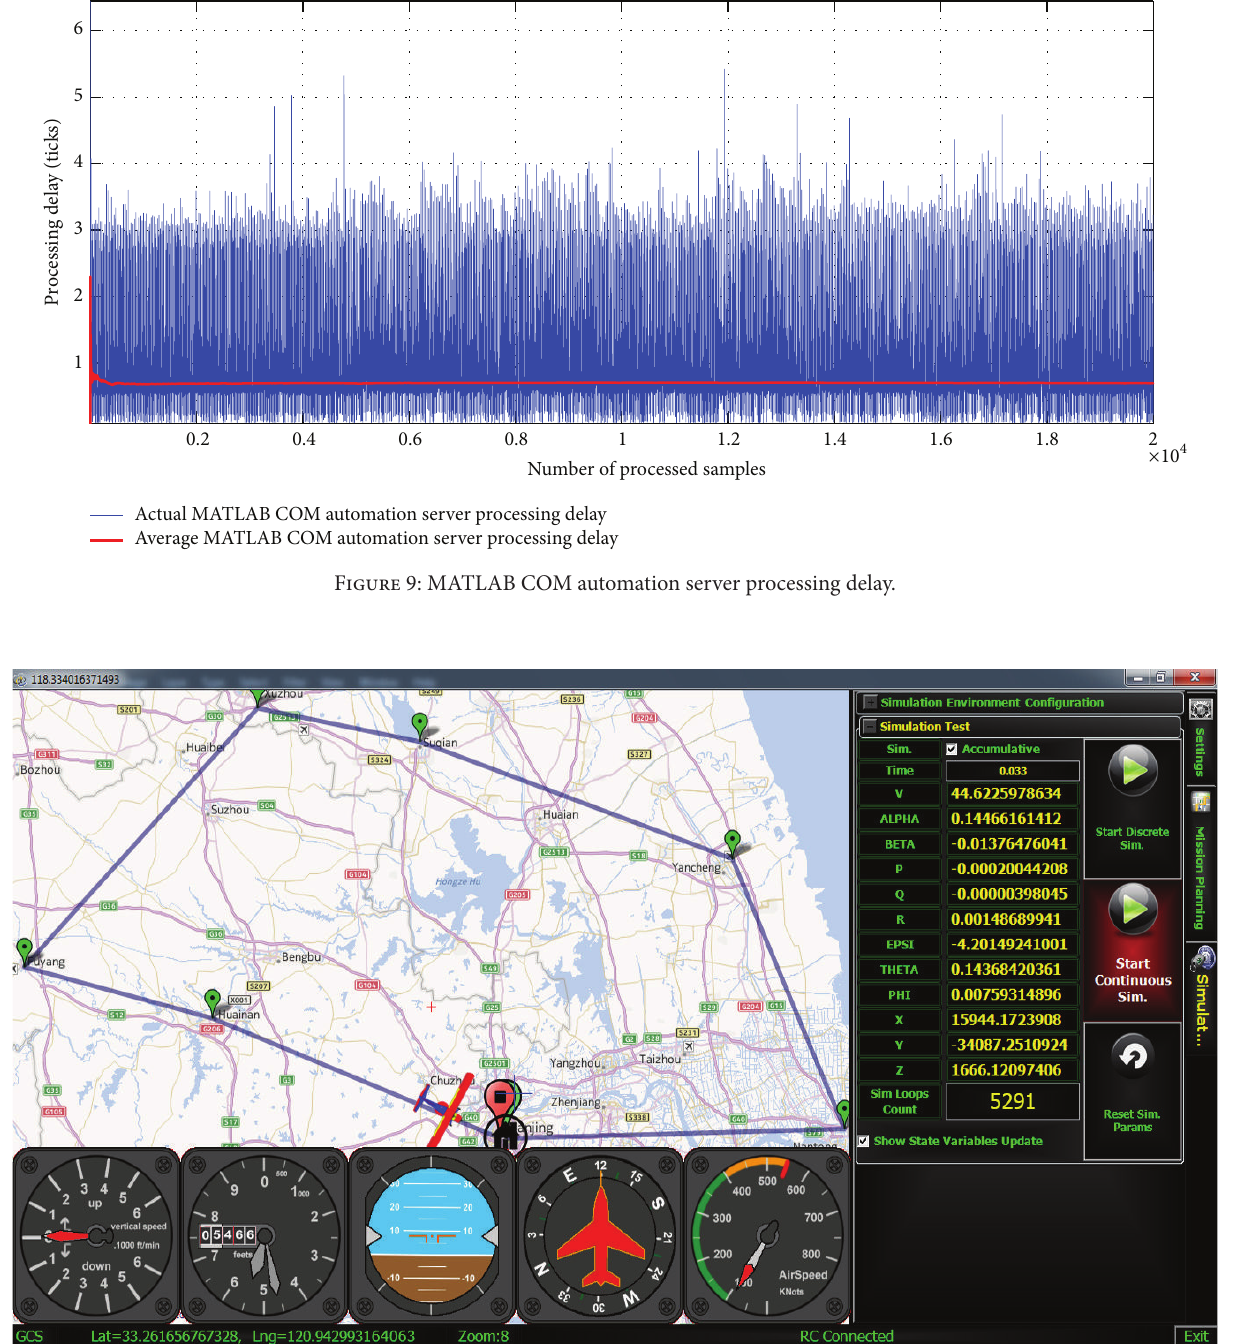
Figure 10: Proposed hybrid simulator HMI